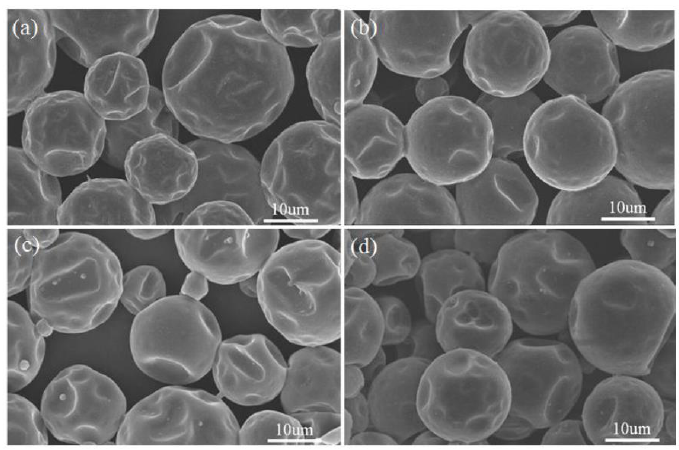
Figure 2. SEM micrographs of various MicroPCMs: ( a ) polyurea microcapsules; ( b ) polyurethane microcapsules; ( c ) polyurea–SiO 2 microcapsules; ( d ) polyurethane–SiO 2 microcapsules.